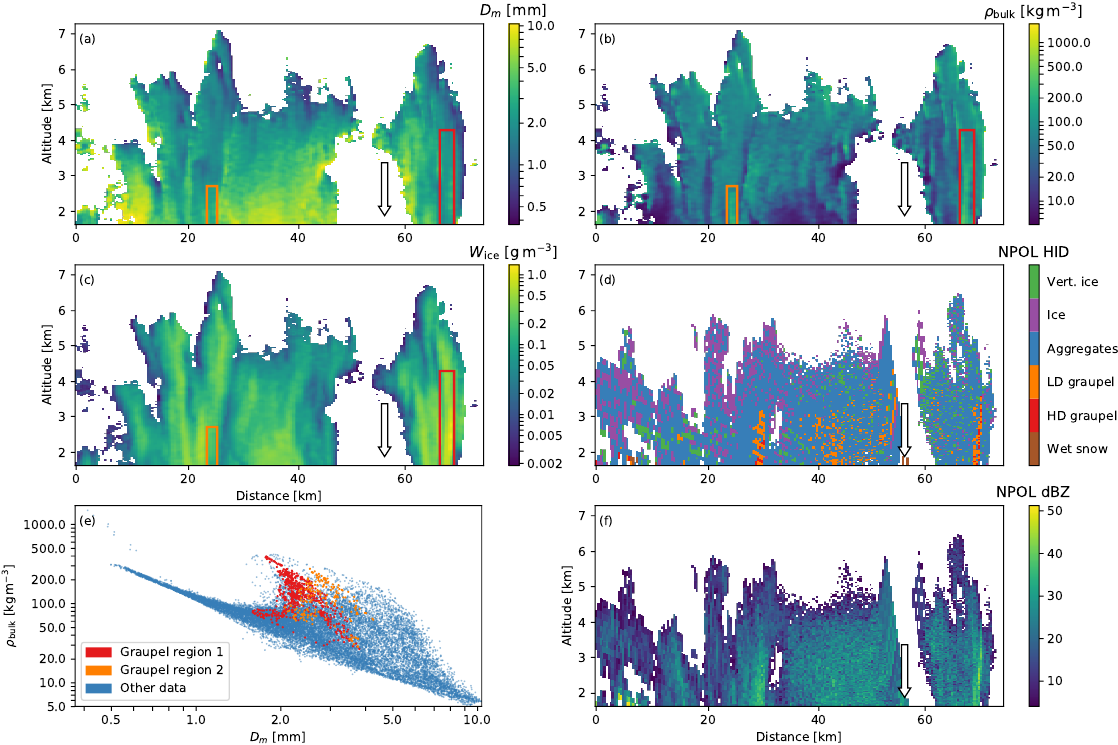
Figure 3. As Fig. 2, except for the 4 December 2015 case described in Sect. 5.2. The location of NPOL on the flight track is marked by the arrow in panels (a) – (d) and (f)